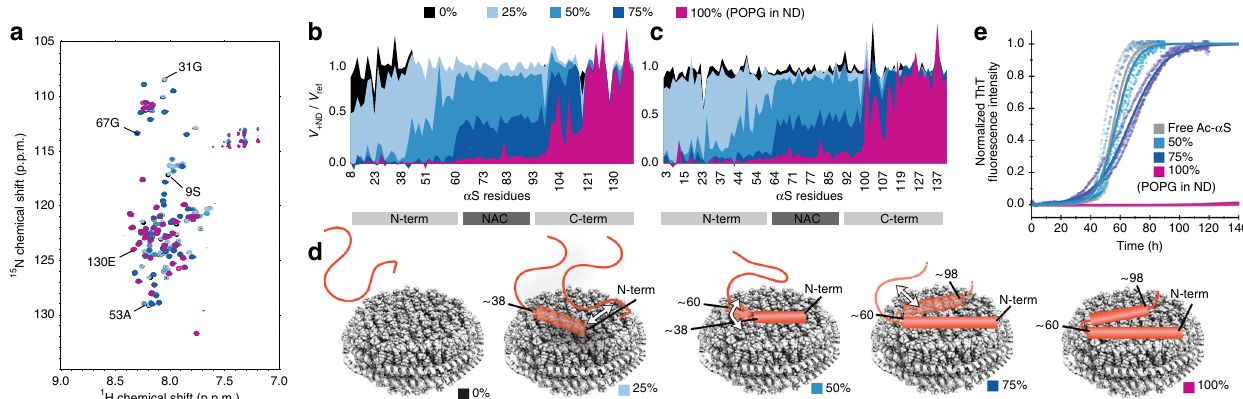
Fig. 1 Lipid charge content modulates α S membrane binding modes and different binding modes show different effects on α S aggregation. a NMR [ 15 N- 1 H]- TROSY-HSQC spectra of [ 15 N]- α S (50 µ M) in the absence (gray) or in the presence of 25 µ M NDs containing an increasing amount of the anionic lipid POPG complemented with the zwitterionic lipid DMPC (0% POPG (black), 25% POPG (light blue), 50% POPG (blue), 75% POPG (dark blue), and 100% POPG (purple)). Selected residue assignments corresponding to differently affected parts of α S are indicated. Corresponding NMR attenuation pro fi les, i.e., the ratio of peak volumes in the presence and absence of NDs, are plotted against α S primary sequence for acetylated b and non-acetylated c α S. d Molecular model visualizing the gradual binding of different parts of α S to NDs with increasing charge content. White arrows and transparent coloring indicate α S regions that experience intermediate NMR-signal attenuation indicative of multiple (dynamic or static) states. e α S aggregation assays (normalized ThT fl uorescence) in the absence and presence of NDs with indicated POPG content for acetylated α S (concentration of α S and NDs identical to NMR data in a – c , data of triplicate measurements until reaching saturation and their respective fi ts are shown, color code as in a – c